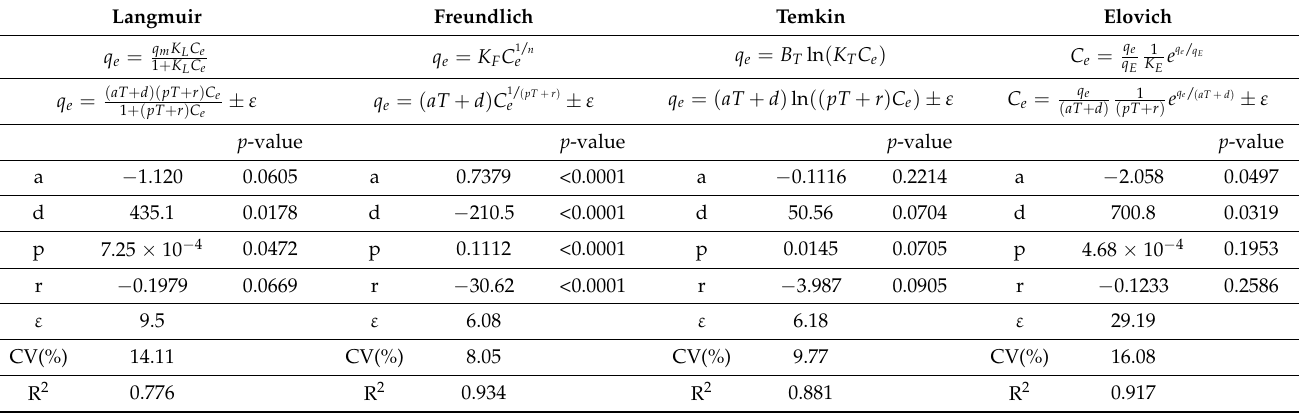
Table 2. Adsorption isotherms, nonlinear fitting parameters and statistics for Ag(I) biosorption with Rhodotorula mucilaginosa